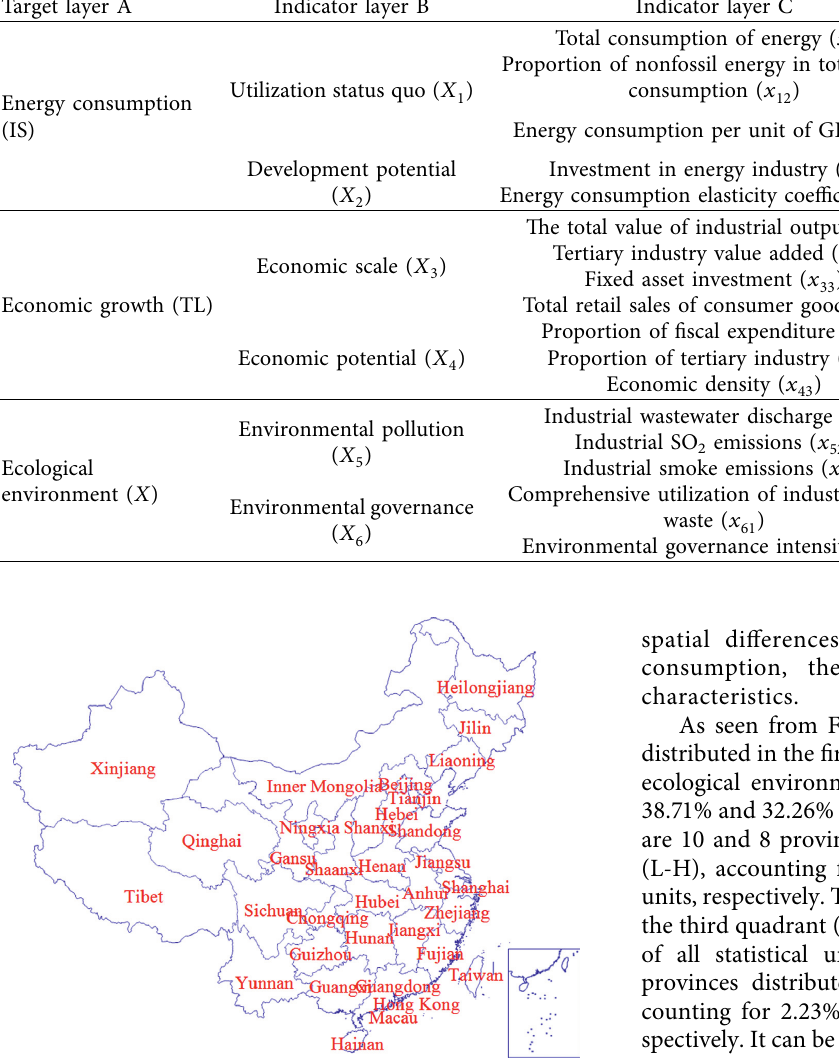
Figure 1: China provincial administrative zoning